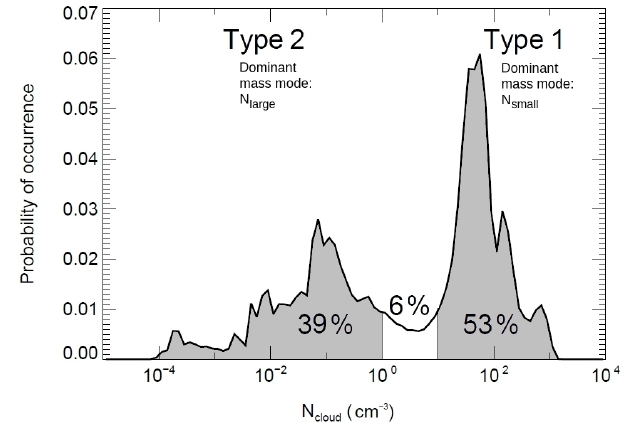
Figure 6. Histogram of cloud particle concentrations ( D p 3 to 937µm) of Type 1 and Type 2 clouds in the mixed-phase tem- perature regime between 0 and − 38 ◦ C (273 to 235K). For cloud type definitions see Sect. 3.1. The 6% between the two clear modes were classified as “Type 1” in this study. N small is particles with diameters between 3 and 50µm. N large is particles with diameters > 50µm. N cloud is all particles with diameters of 3µm and